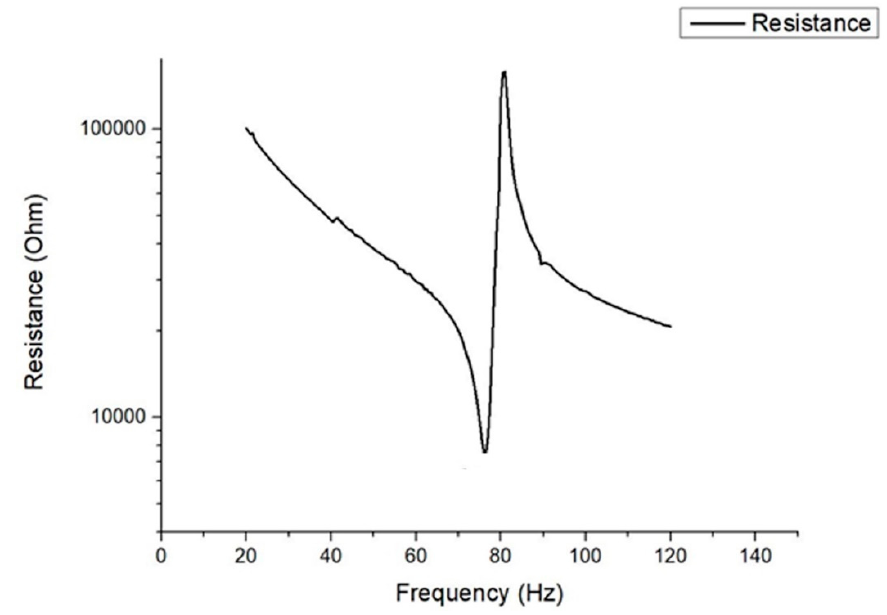
Figure 20. Graph of Optimal Resistance against Frequency obtained from Impedance Analyzer.